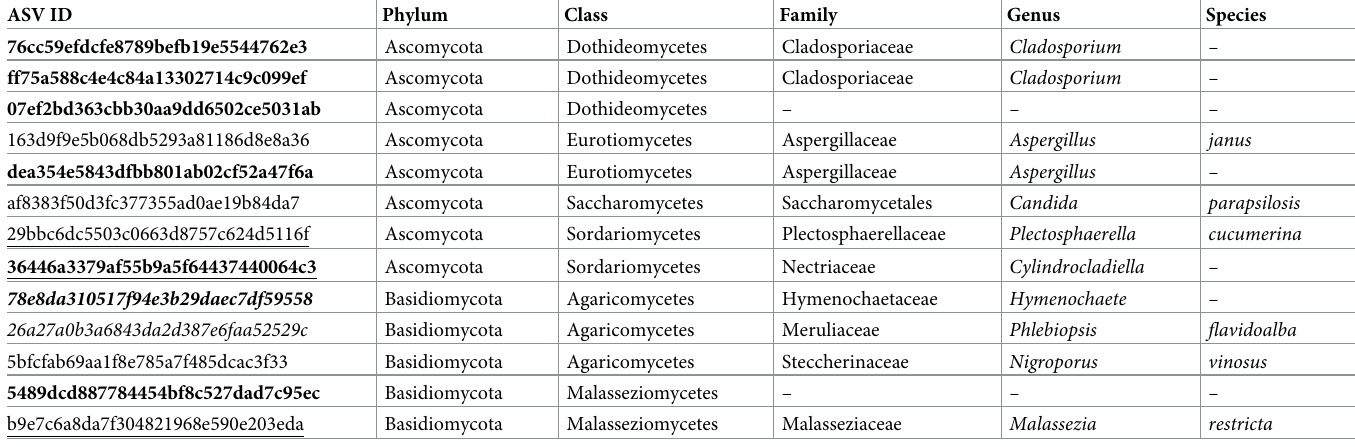
Table 1. Fungal ASVs present in biofertilizer. Fungal ASVs that were detected in coffee soils are in bold. Five ASVs could be categorized into a trophic mode using FUN- guild and our criterion for assignment: three were ‘probable’ pathotrophs (ASV ID underlined) and two were ‘probable’ saprotrophs (ASV ID italicized). ASV